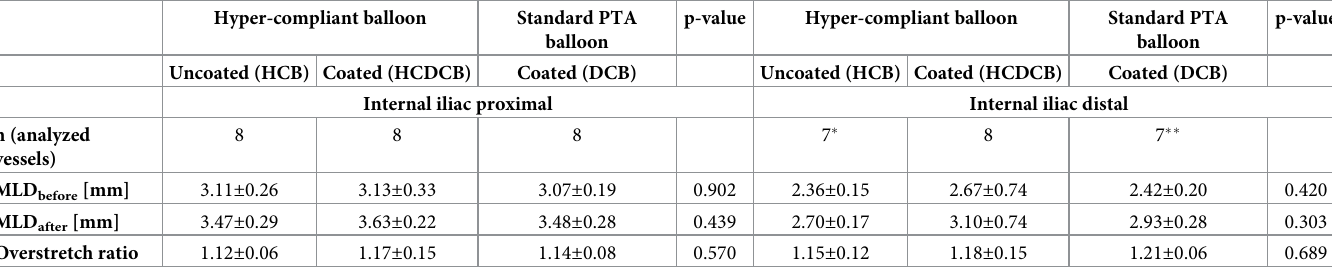
Table 4. Quantitative angiography (QA) of each vessel segment of internal iliac arteries before and after